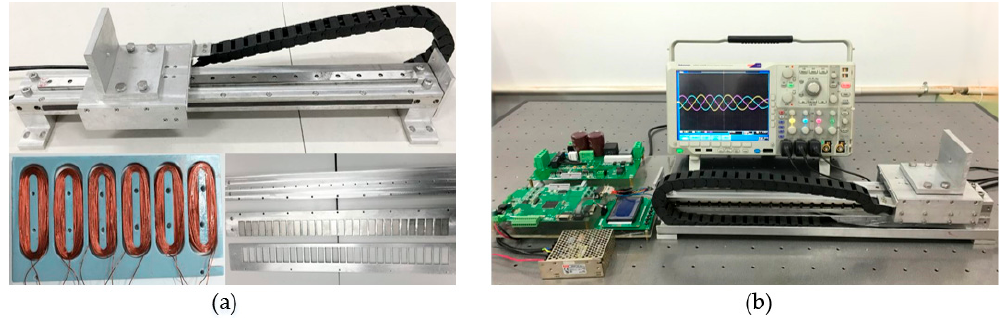
Figure 11. Test platform for the manufactured PMSLM: ( a ) Prototype of PMSLM; and ( b ) Test platform. In Figure 12, the no-load inductive electromotive force (EMF) lines and harmonic analysis of the Taguchi method, new method, and experimental method are respectively shown.